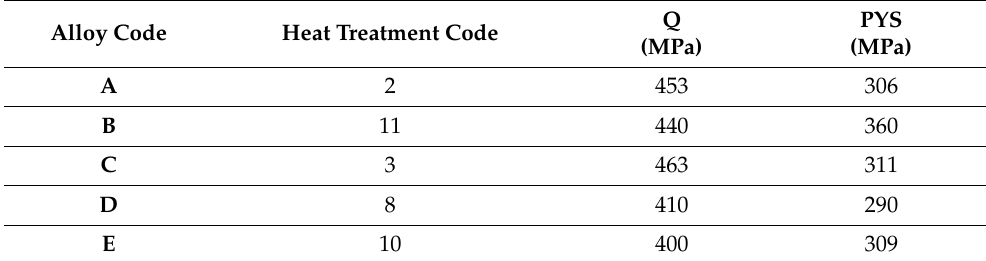
Table 6. Appropriate composition and heat treatment for the five alloys studied.